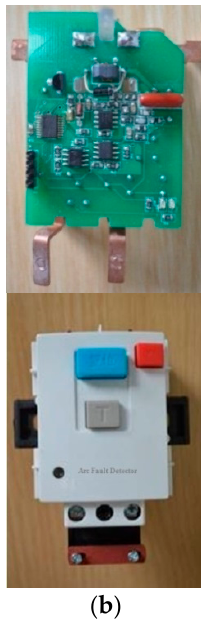
Figure 19. AFD: ( a ) schematic; ( b ) prototype. Figure 20. AFD: ( a ) schematic; ( b ) prototype.